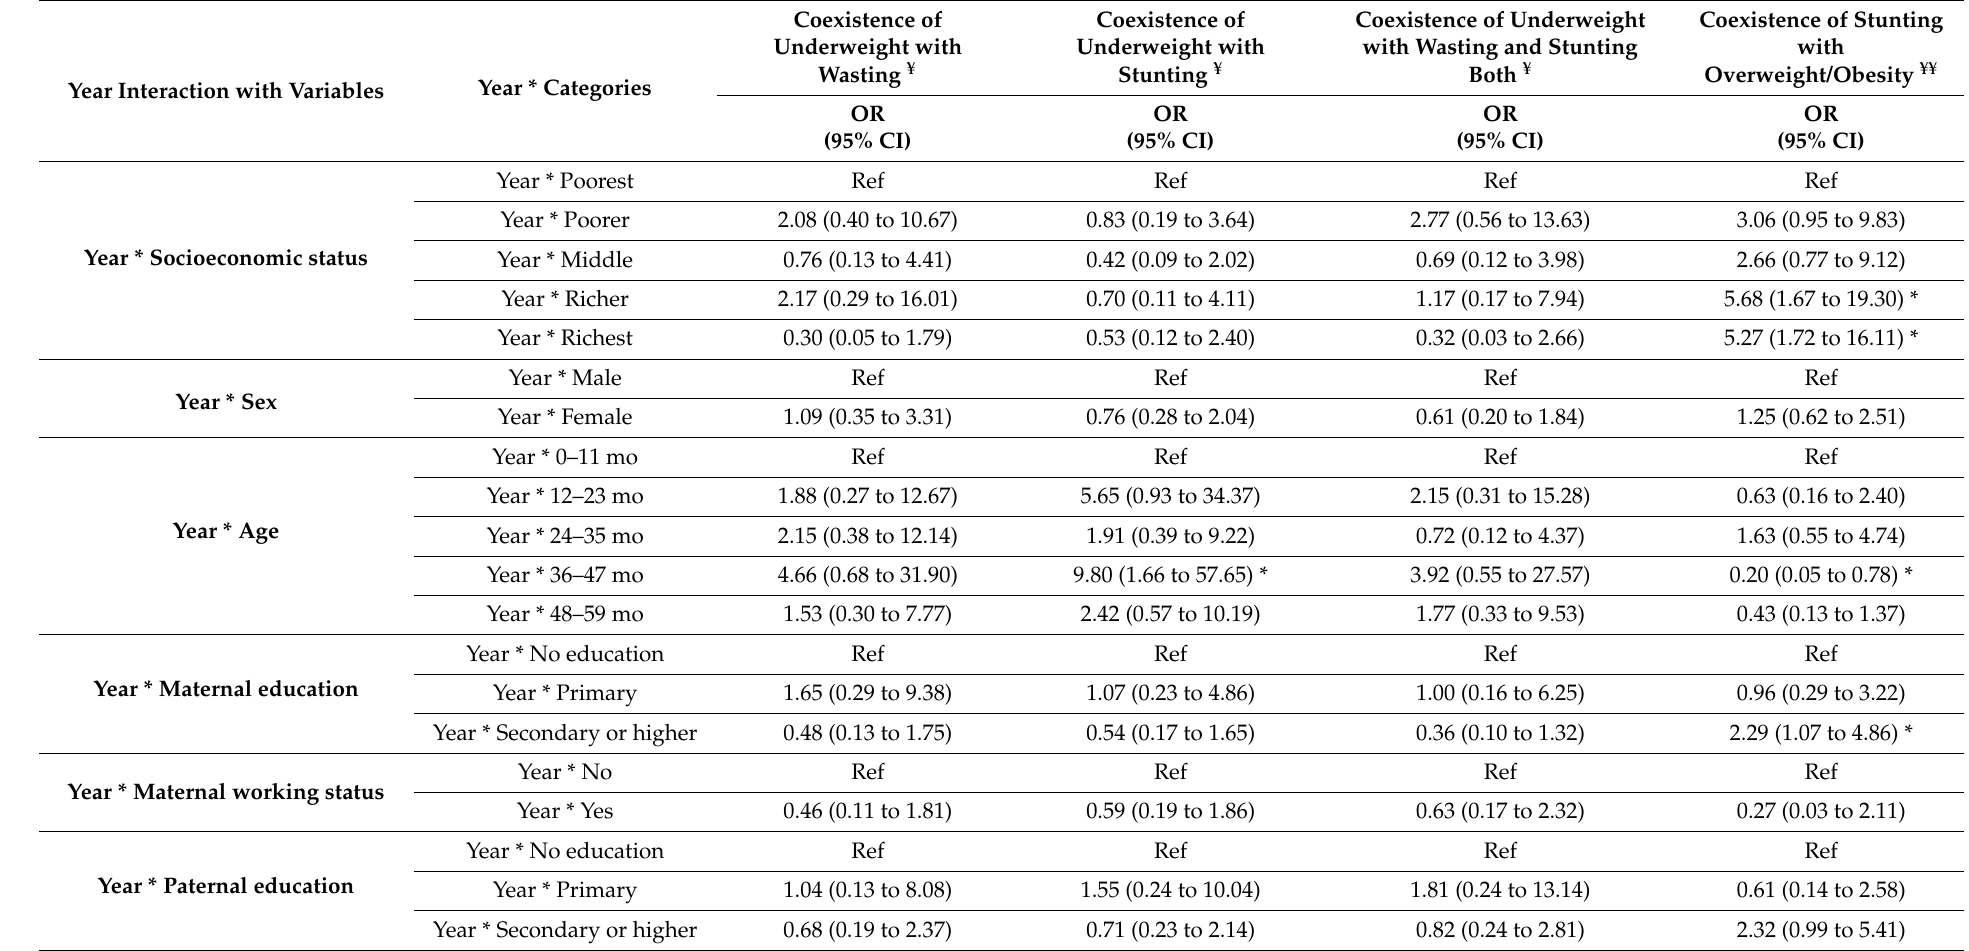
Table 3. Assessing the interaction of different covariates with various forms of coexisting forms of malnutrition across two survey